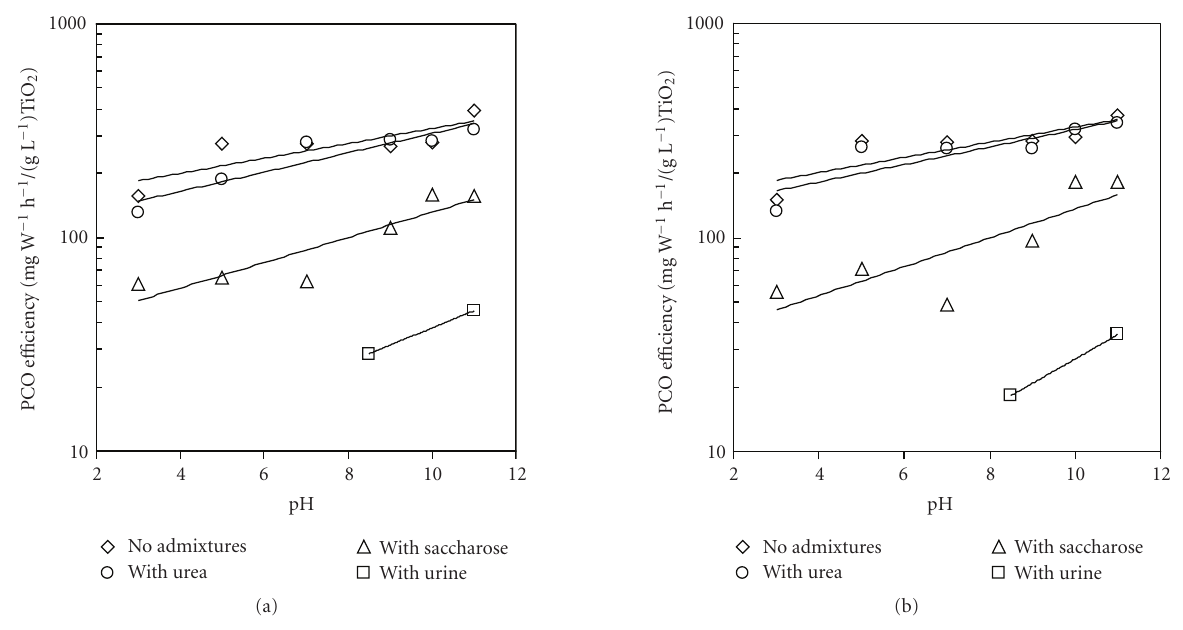
Figure 2: The dependence of the PCO e ffi ciency of E2 (a) and EE2 (b) pH: treatment time 15 minutes and 10mg L − 1 TiO 2 except urine-120 minutes and 1g L − 1 ,